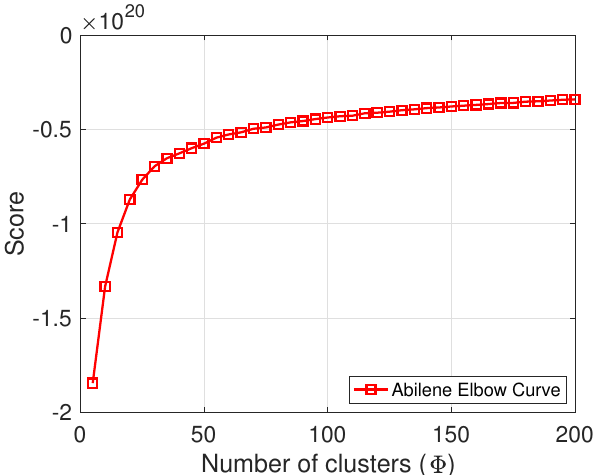
Figure 3. Score of K-means vs. number of clusters ( φ ).